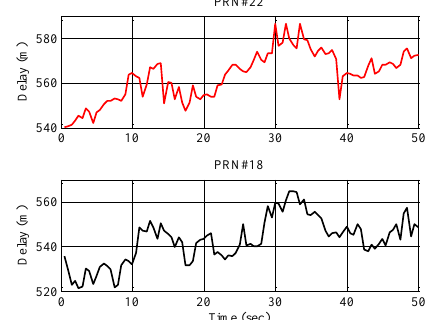
Figue 16. Delay of the reflected signal relative to the direct signal associated with two satellites.